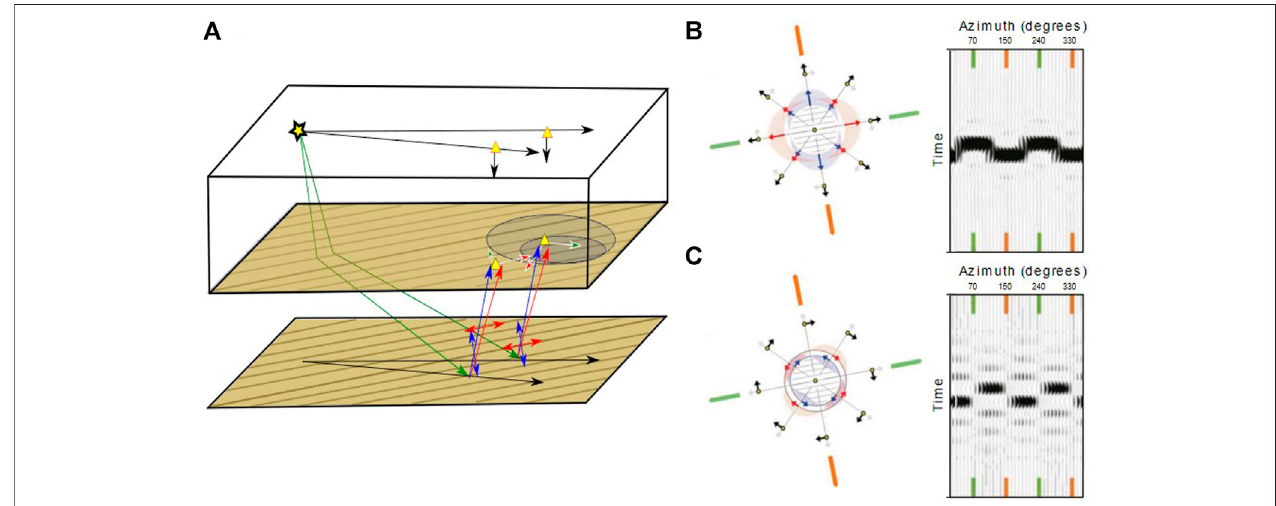
FIGURE1 | Diagramillustrating shear wave splitting (modi fi ed after Bale et al.,2009) at twoocean bottom seismometerslocated in, or close to apockmark, sitting within seabed sediments containing vertical parallel fractures (HTI). (A) The pockmarks are shown as concentric circles on the seabed. Direction of shading indicates orientationoftheverticalfractures.Thelowersurface(re fl ector)isthebaseoftheanisotropiclayer,acrosswhichS-waveconversionoccurs.Yellowstarshowslocationof anairgunshotneartheseasurface.Yellow trianglesareoceanbottomseismometers:blackoutline (cid:2) onsea fl oor,red outline (cid:2) projectedtoseasurface,toindicate the sagittal (shot – receiver) azimuth. Radial and transverse directions are indicated by black arrows. The white arrows represent the horizontal geophone orientations: green (cid:2) X;red (cid:2) Ycomponent.Thegreenarrowisthedown-goingP-wavephase.Fast(S1)andslow(S2)S-wavesarerepresentedwithredandbluearrowsrespectively and their particle motions are indicated by double-ended red and blue arrows. (B) Aligned vertical fractures with 70 ° N azimuth viewed from the top indicating the amplitudes of fast (red arrows) and slow (blue arrows) S-waves in radial direction (black arrows) and corresponding radial seismogram. Green and orange arrows lines indicate the fracture parallel and fracture perpendicular directions. (C) same as b, transverse component. The presence of HTI is easily identi fi able from the azimuthal variation seen on the radial and transverse components.